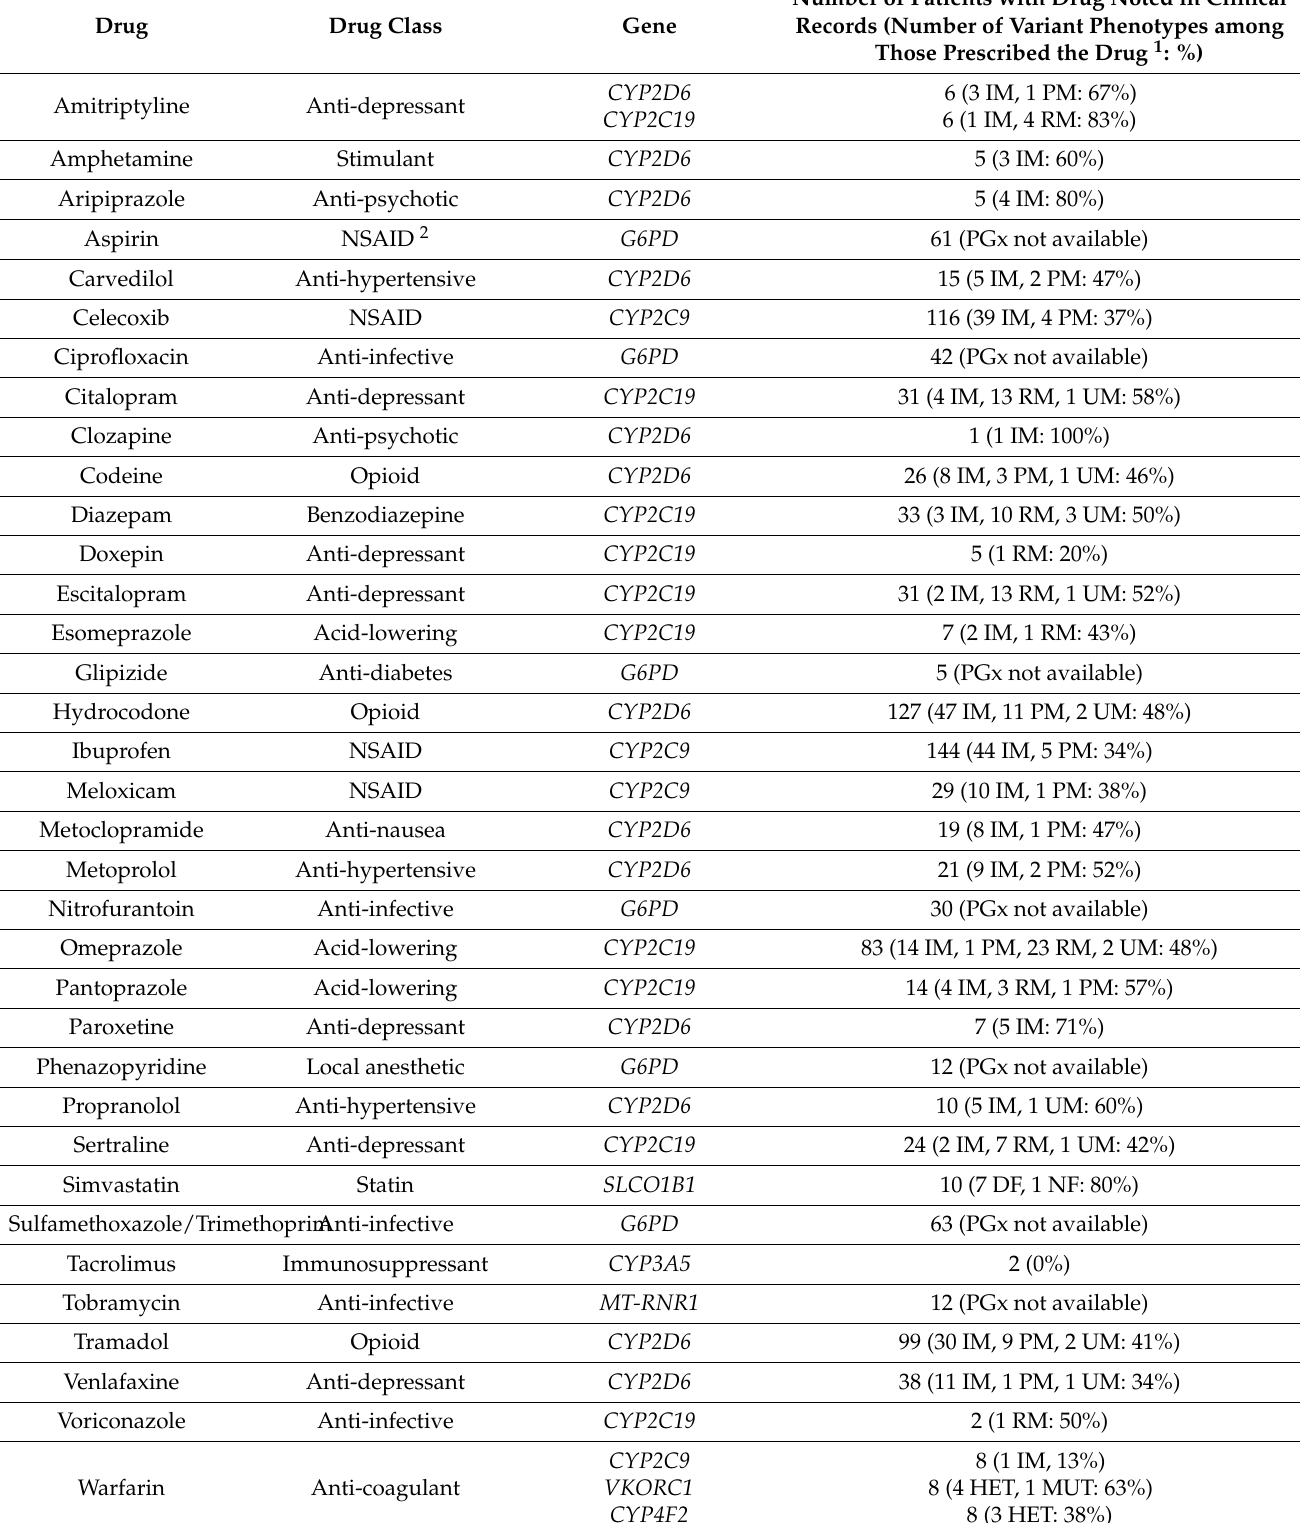
Table 2. Drug–gene (germline) pairs with relevance to the patients with breast cancer: non-cancer therapy. Drug Drug Class Gene